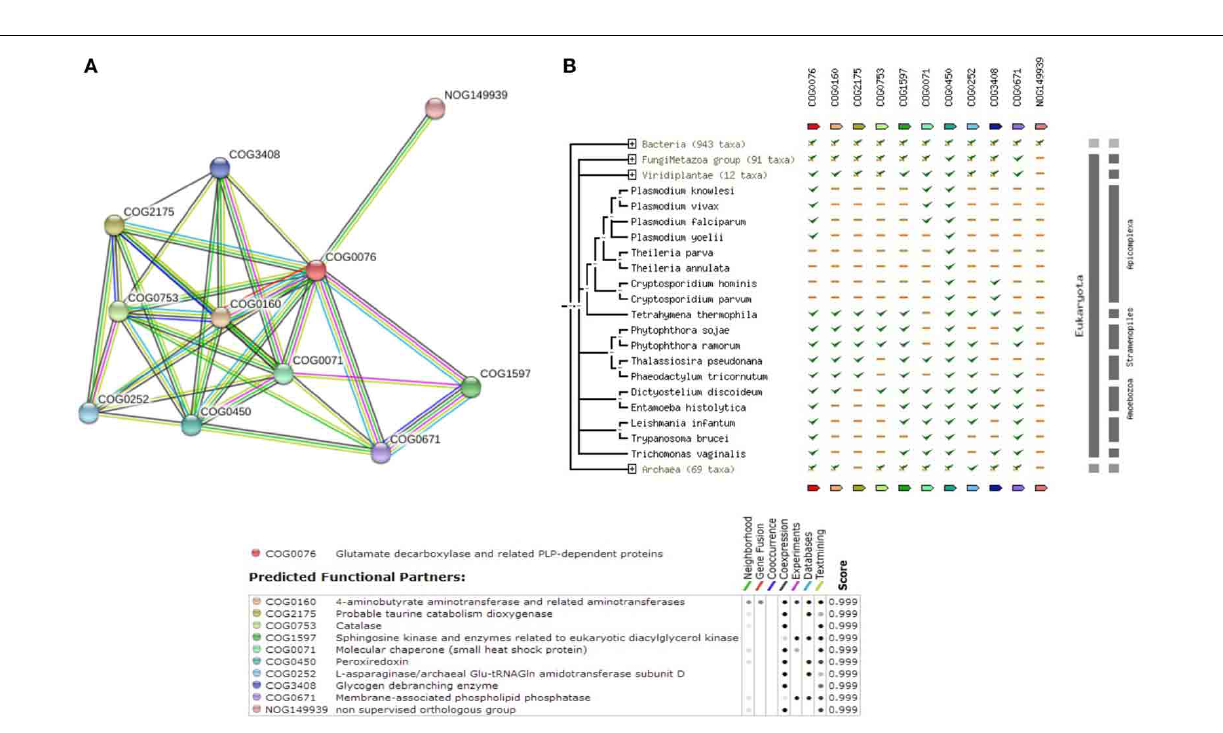
FIGURE 7 | (A) COG network display for members of Seleno-cysteine metabolism Pathway. (B) Phylogenetic profile of the members of Seleno-cysteine metabolism Pathway.